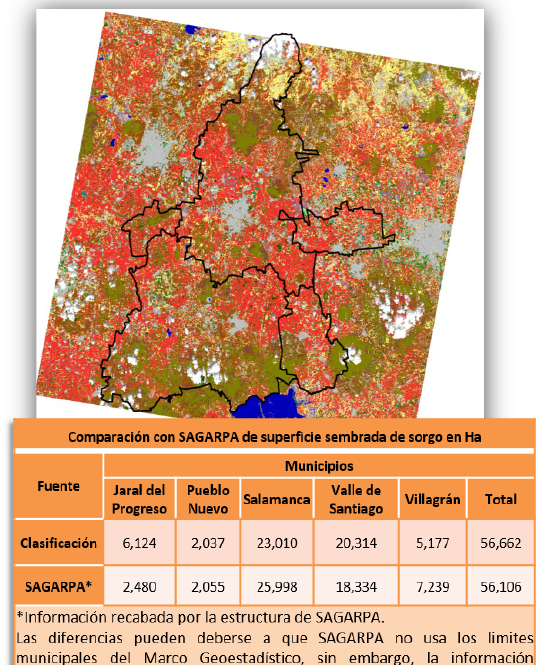
Figure 2. Results obtained by SAGARPA and INEGI.